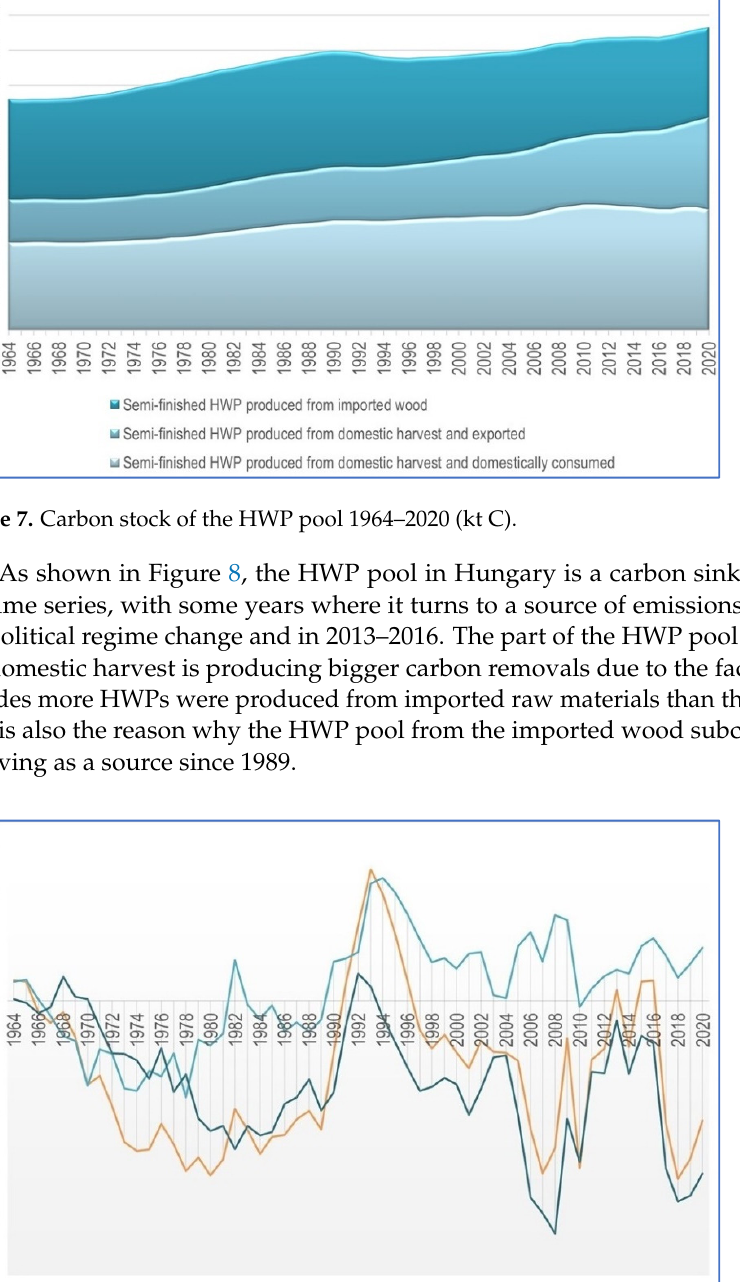
Figure 9. Historic and predicted emissions and removals from the HWP pool for time period of 1964–2070 (kt CO 2 ). 4. Discussion Our results show that the Hungarian HWP pool is storing a significant amount of carbon, which has been continuously increasing since the 1960s. However, as the projected